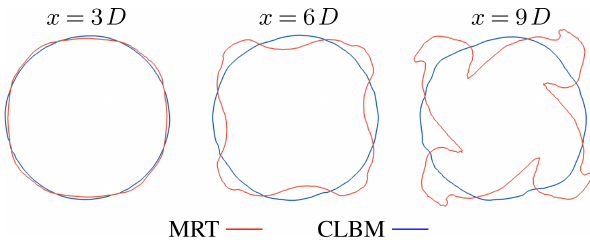
Figure A1. Instantaneous velocity contours ( u = 0 . 875 u 0 ) in cross-sectional planes at different positions in the wake of the tur-